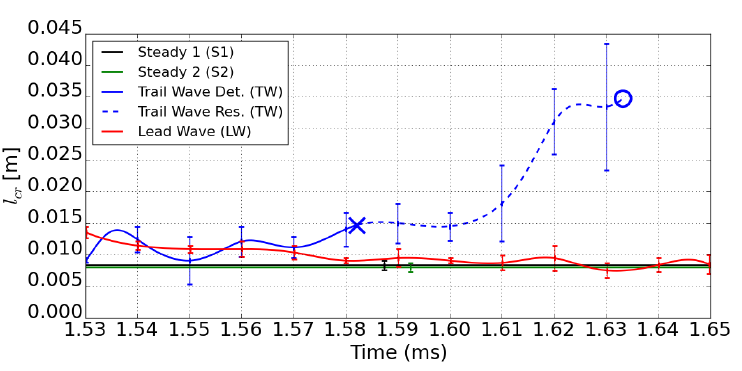
Figure 18. Critical axial reactant mixing height ( l cr ) via Wolanski wave stability criterion for detona- tion wave